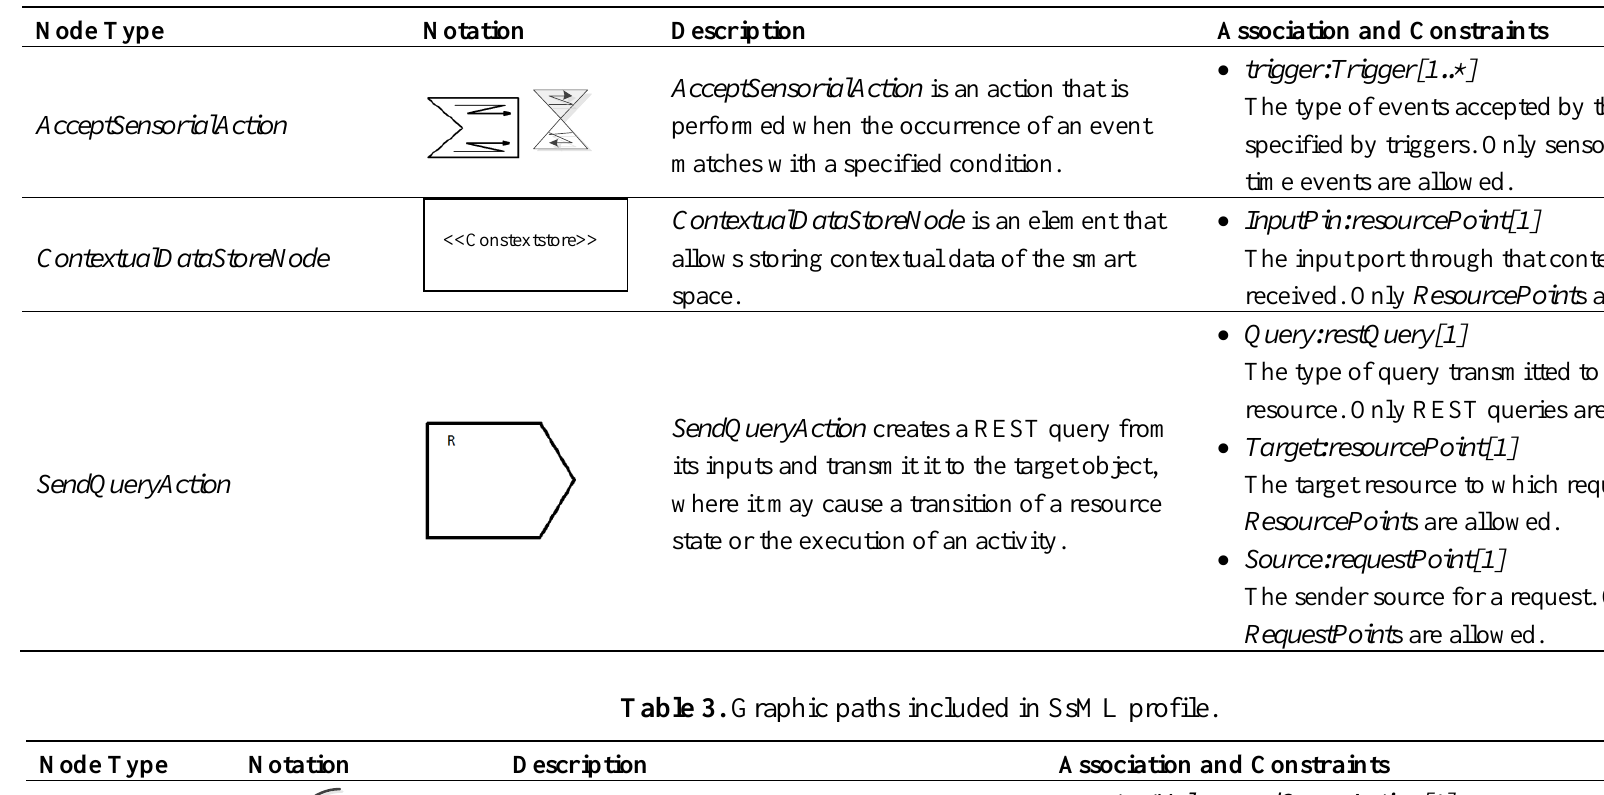
Table 2. Graphic nodes included in SsML profile.